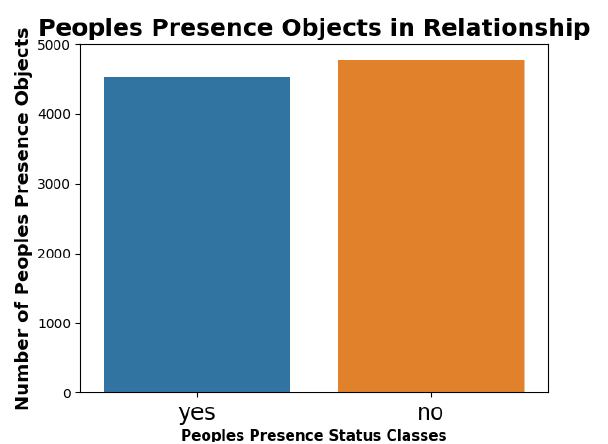
Figure 13. People presence objects in relationship.